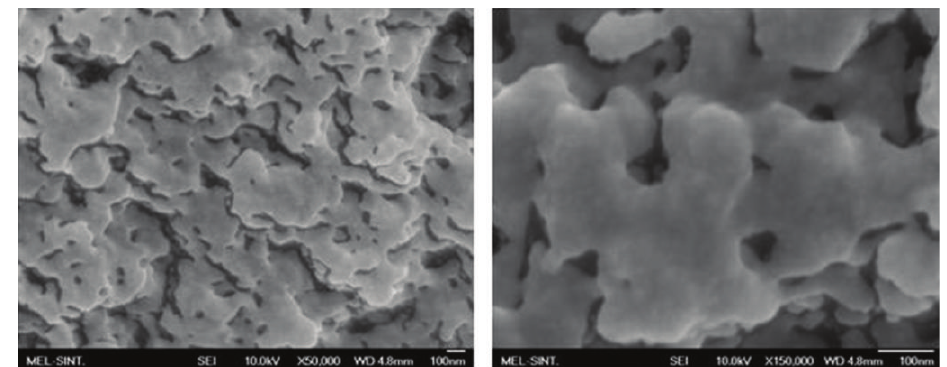
Figure 8: SEM images of synthetic melanin.